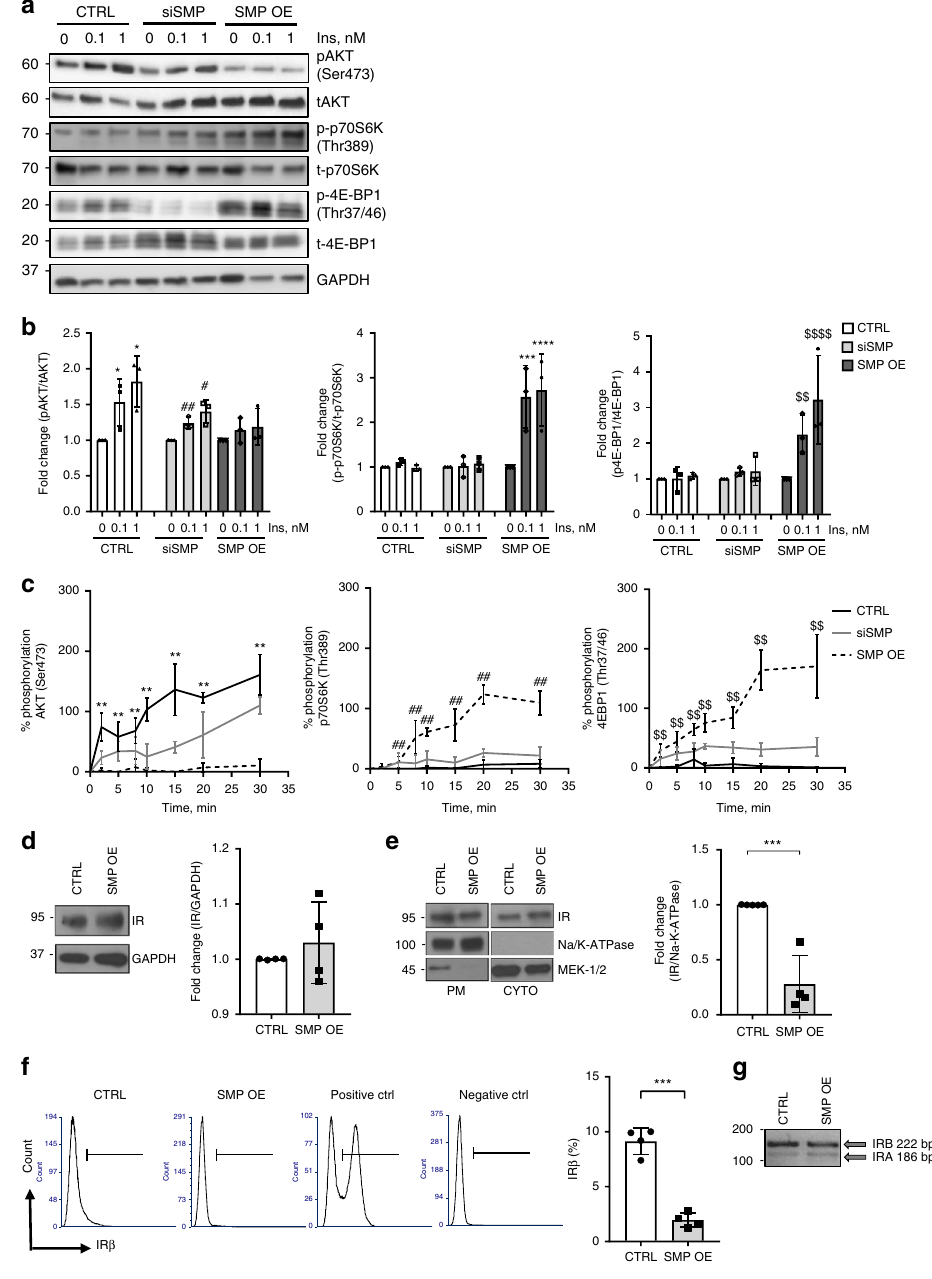
overexpressing cells. We found that CD increased AKT phos- phorylation (Fig. 3e) without affecting p70S6K phosphorylation (Fig. 3e). Additionally, CD treatment of transfected HEK293 cells resulted in restored interaction between IRB and caveolin-1 in presence of SMPDL3b overexpression, while IRA/caveolin-1 interaction was compromised (Fig. 3f). This occurred in asso- ciation with increased IR and decreased SMPDL3b localization at the PM (Fig. 3g). While it is not possible to discriminate with this model if CD differentially affects IRA or IRB localization, the observed increase in AKT phosphorylation in the absence of changes in p70S6K phosphorylation suggests that CD primarily restores the PM localization of IRB. The generation of Smpdl3b fl oxed mice is described in detail